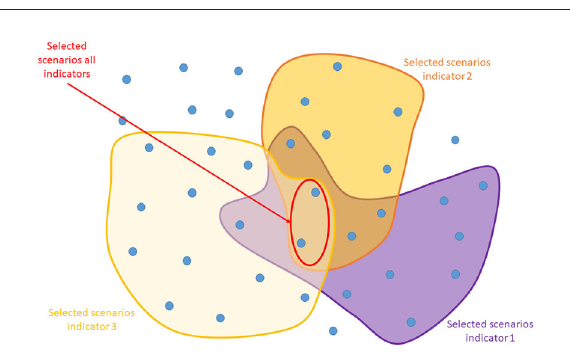
FIGURE5 Systematic representation of selection of favorable scenarios: each blue dot represents a scenario; one ensemble represents scenarios complying with the target for one indicator.